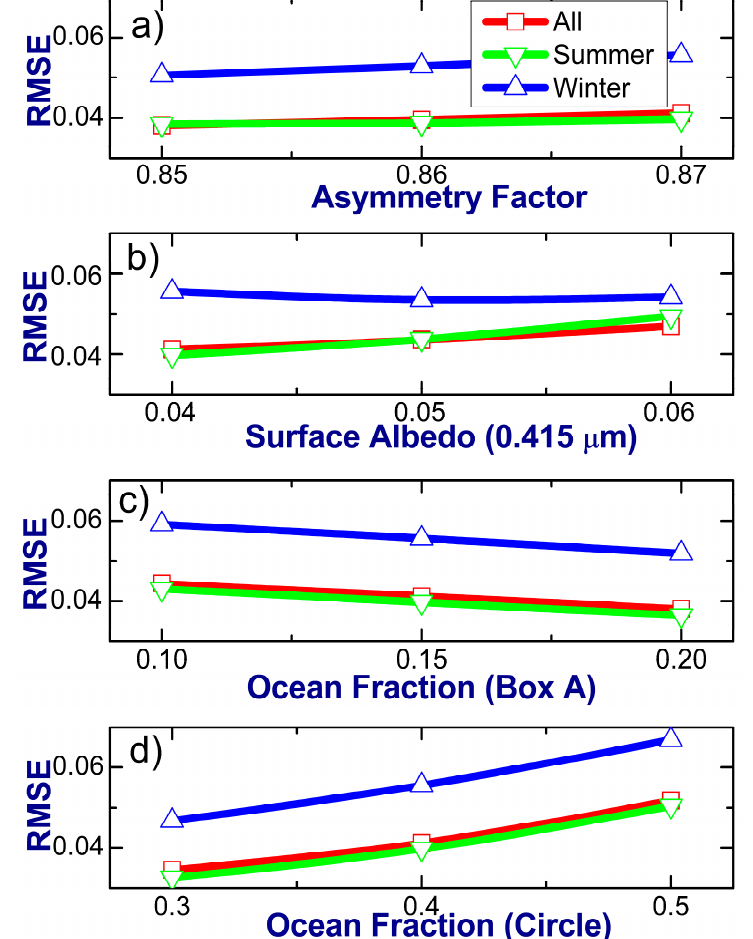
Figure 4. The calculated RMSE as a function of the assumed asymmetry factor ( a ), surface albedo at 0.415 µ m wavelength ( b ), fractions of the ocean areas within box A ( c ), and circle ( d ). The calculated RMSE for the 19-month period of interest (All) and two seasons (Summer and Winter) are indicated by red, green and blue colors,